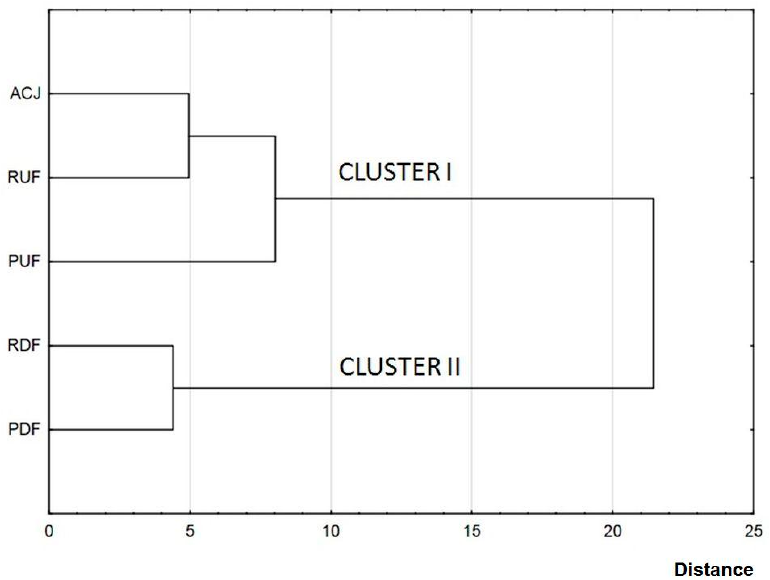
Figure 4. Discrimination of apple-cranberry cloudy juice samples before and after membrane processing based on hierarchical cluster analysis (HCA) of FTIR spectra (B).